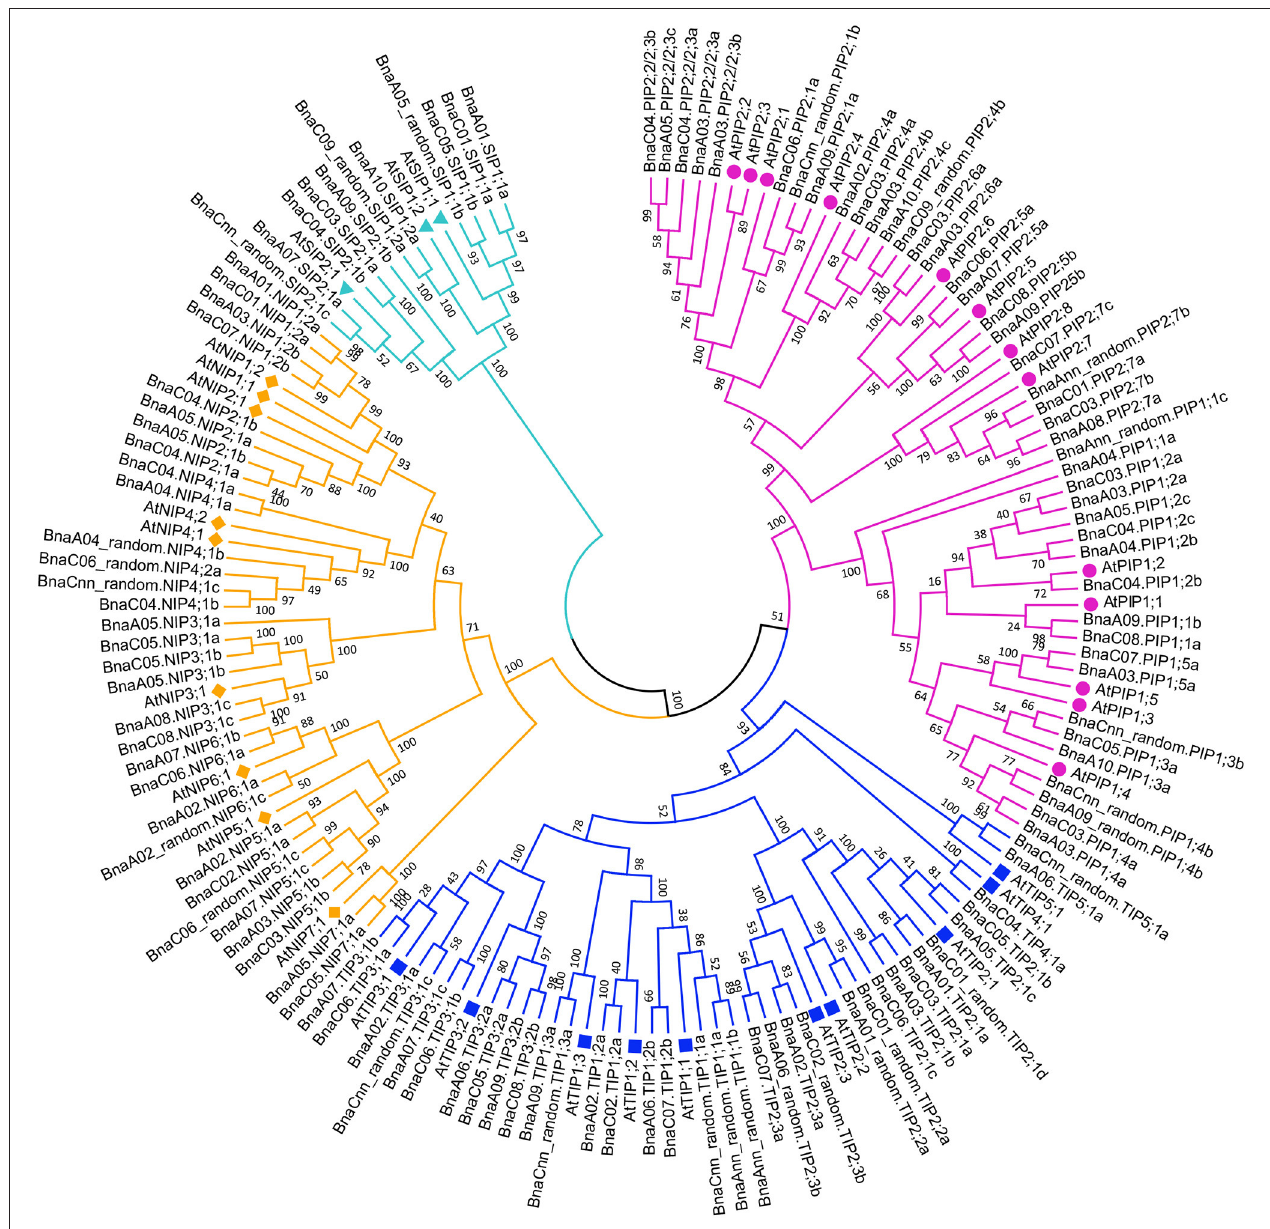
FIGURE 1 | Phylogenetic tree of AQPs in Brassica crops. The AQPs phylogenetic tree was generated by MEGA 5.1 with Neighbor Joining (NJ) method and 1,000 replicates bootstraps, based on the amino acid sequences of 121 BnaAQP genes and 35 AtAQP genes. The gene name with purple, blue, yellow and cyan represented PIPs , TIPs , NIPs, and SIPs , respectively. AtAQPs, AtPIPs, AtTIPs, AtNIPs, and AtSIPs were marked with circle, square, diamond and triangle, respectively.